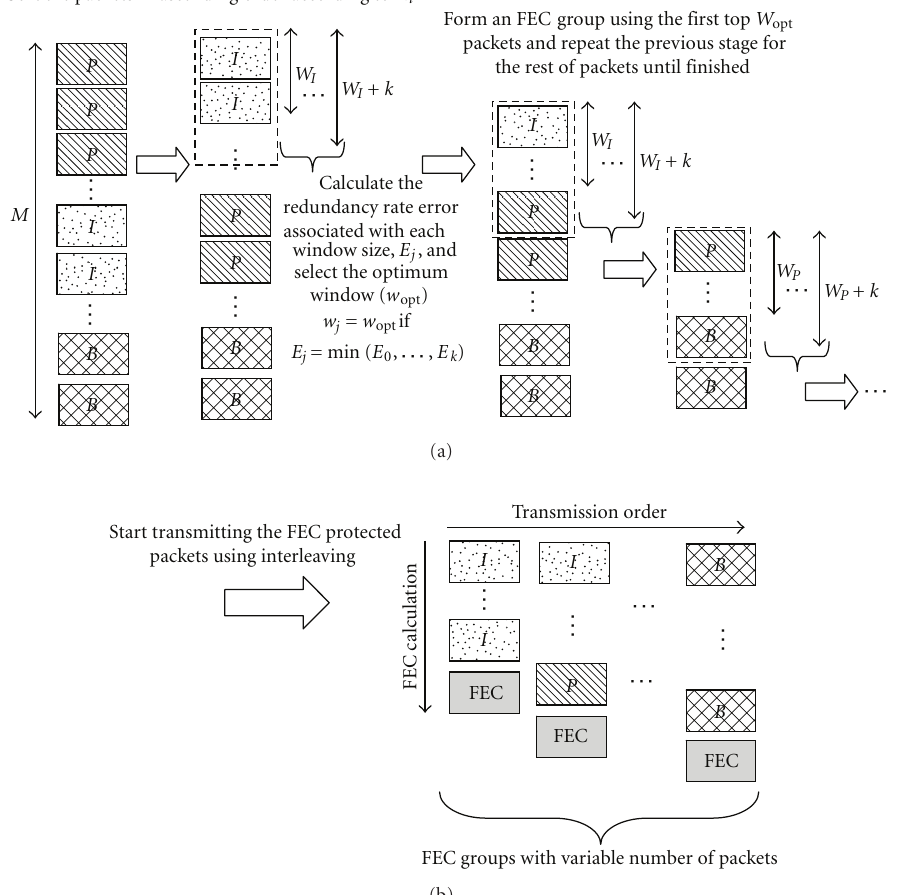
Figure 5: (a) An example of the formation of FEC groups of packets. (b) An example of packet interleaving realization.